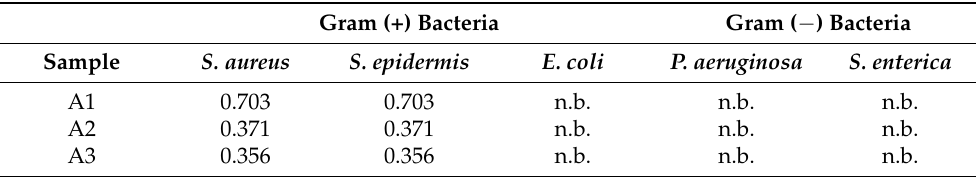
Table 6. Minimum inhibitory concentration of the methanol extract on Gram-positive and Gram- negative bacterial strains expressed as mg ASTRA root powder (DW)/mL.